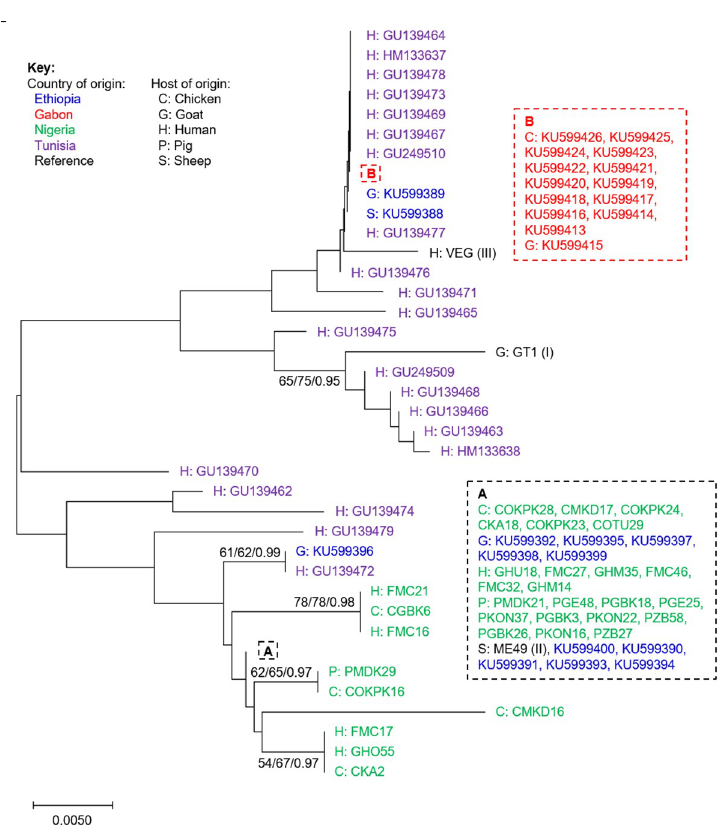
Fig 1. Optimal Maximum Likelihood (ML) phylogenetic tree for Toxoplasma gondii PCR-RFLP SAG3 sequences from Nigerian chickens, pigs and seropositive pregnant women. Generated using an alignment of 226 bp from 84 sequences in total, including 32 new sequences from Nigeria plus published sequences from Ethiopia, Gabon and Tunisia (downloaded from GenBank for comparison, as indicated by accession number). Sequences from the reference GT1, ME49 and VEG strains, representing types I, II and III, were accessed from ToxoDB. Figures at nodes in the format a/b/c represent a: the percentage of trees in which the associated taxa clustered together using ML, b: using Neighbor Joining, and c: posterior probability by Bayesian inference. A and B denote clusters of identical sequences, as indicated in the associated boxes.